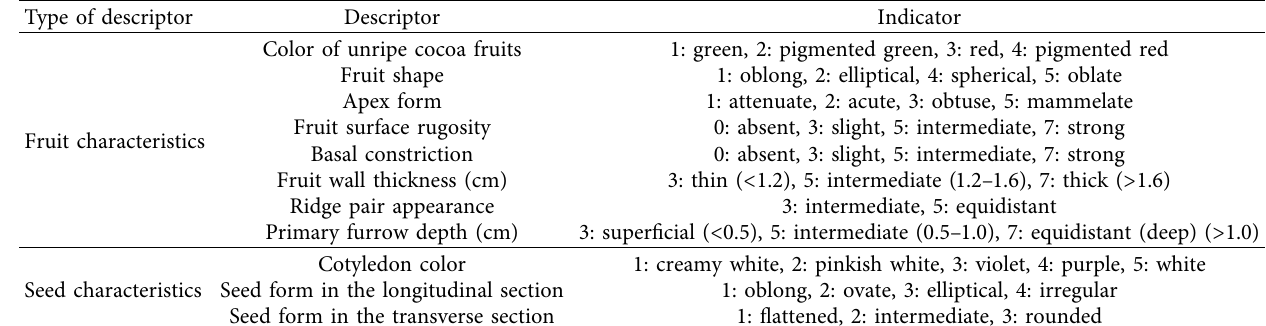
Figure 1: Location of the collection area of the 146 characterised FFNC ecotypes. Table 1: Morphological descriptors of cocoa pods and